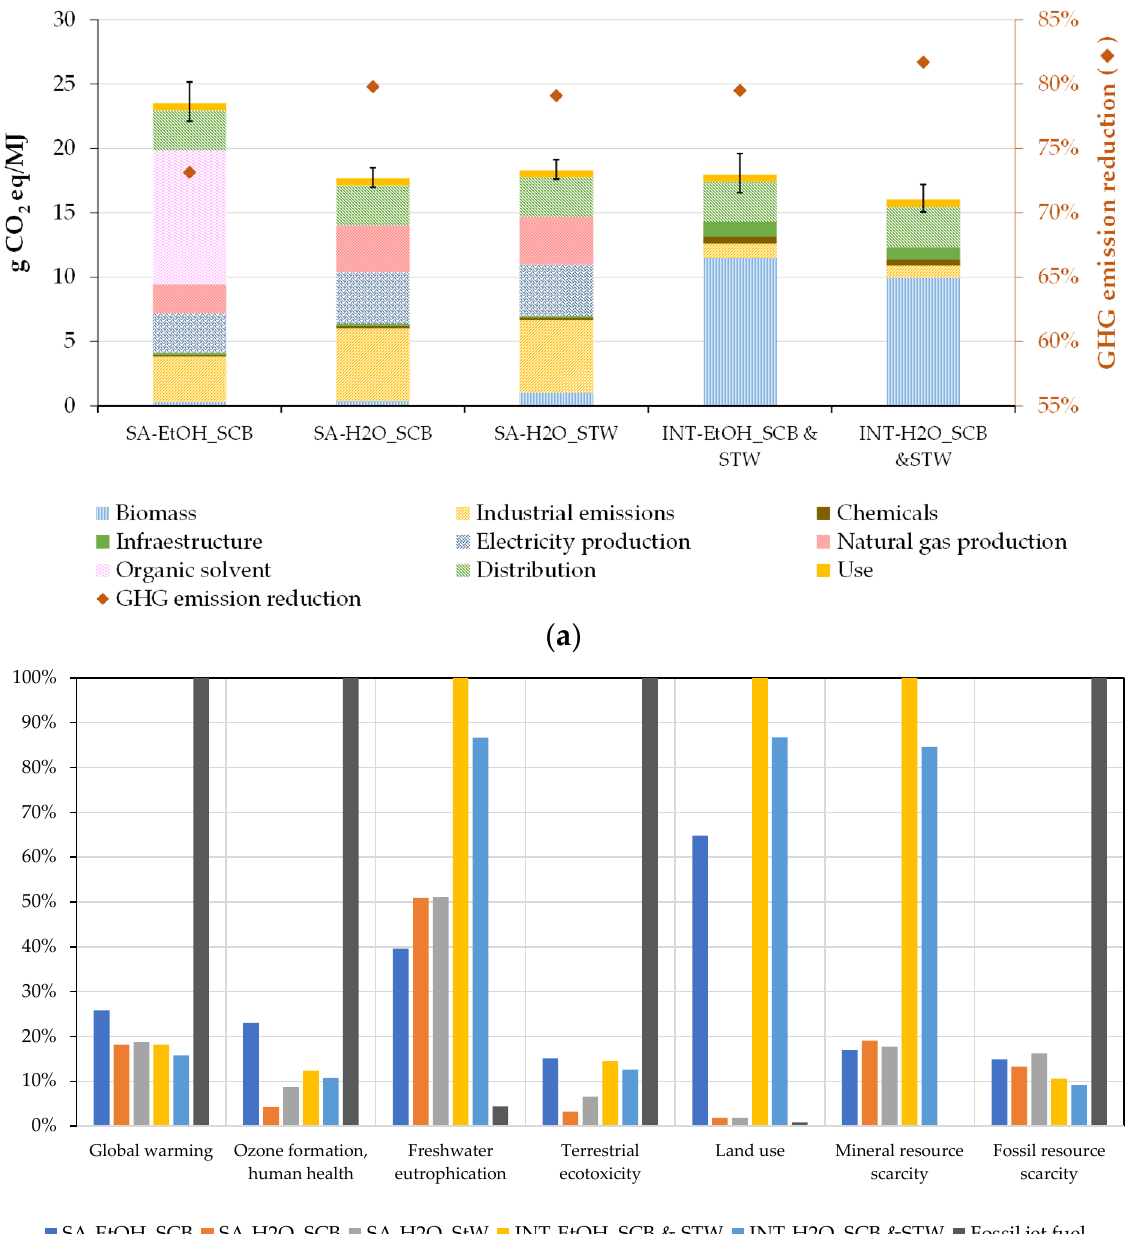
Figure 4. Environmental results of standard aviation fuel in the evaluated scenarios: ( a ) breakdown of GHG emissions, ( b ) selected impact categories.